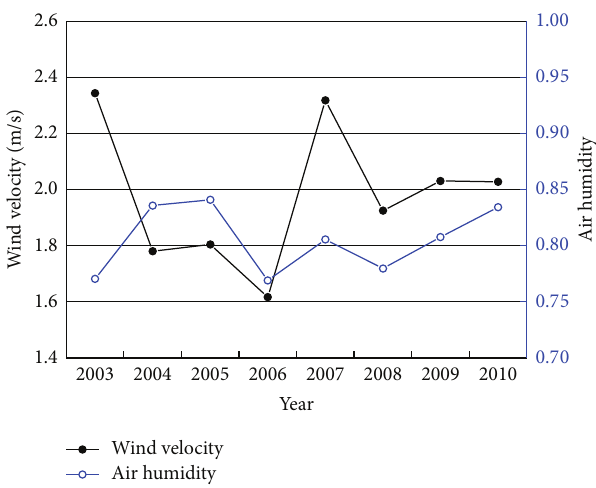
Figure 5: The variation trends of annually averaged air humidity and wind velocity in Dongping Lake during 2003–2010 (open circle means air humidity, dot means wind